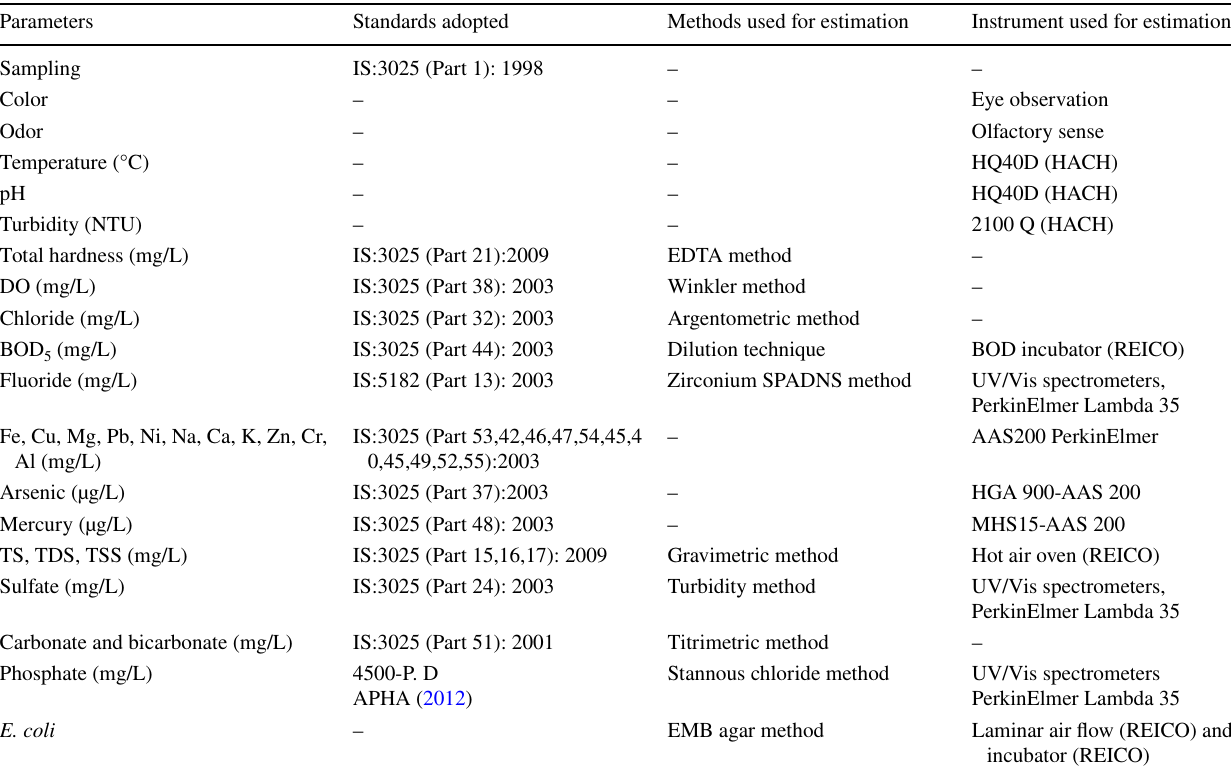
Table 1 Experimental procedure for characterization of kitchen wastewater Parameters Standards adopted Methods used for estimation Instrument used for estimation